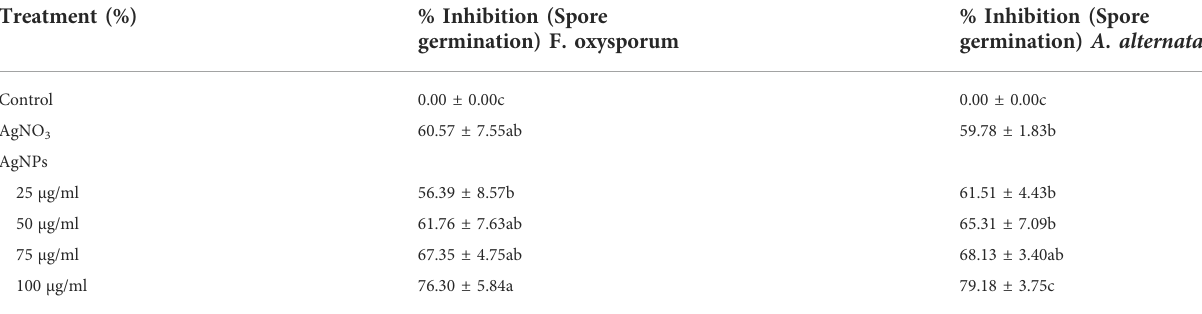
TABLE 5 Inhibition activity of AgNPs on spore germination of F. oxysporum and A. alternata Treatment